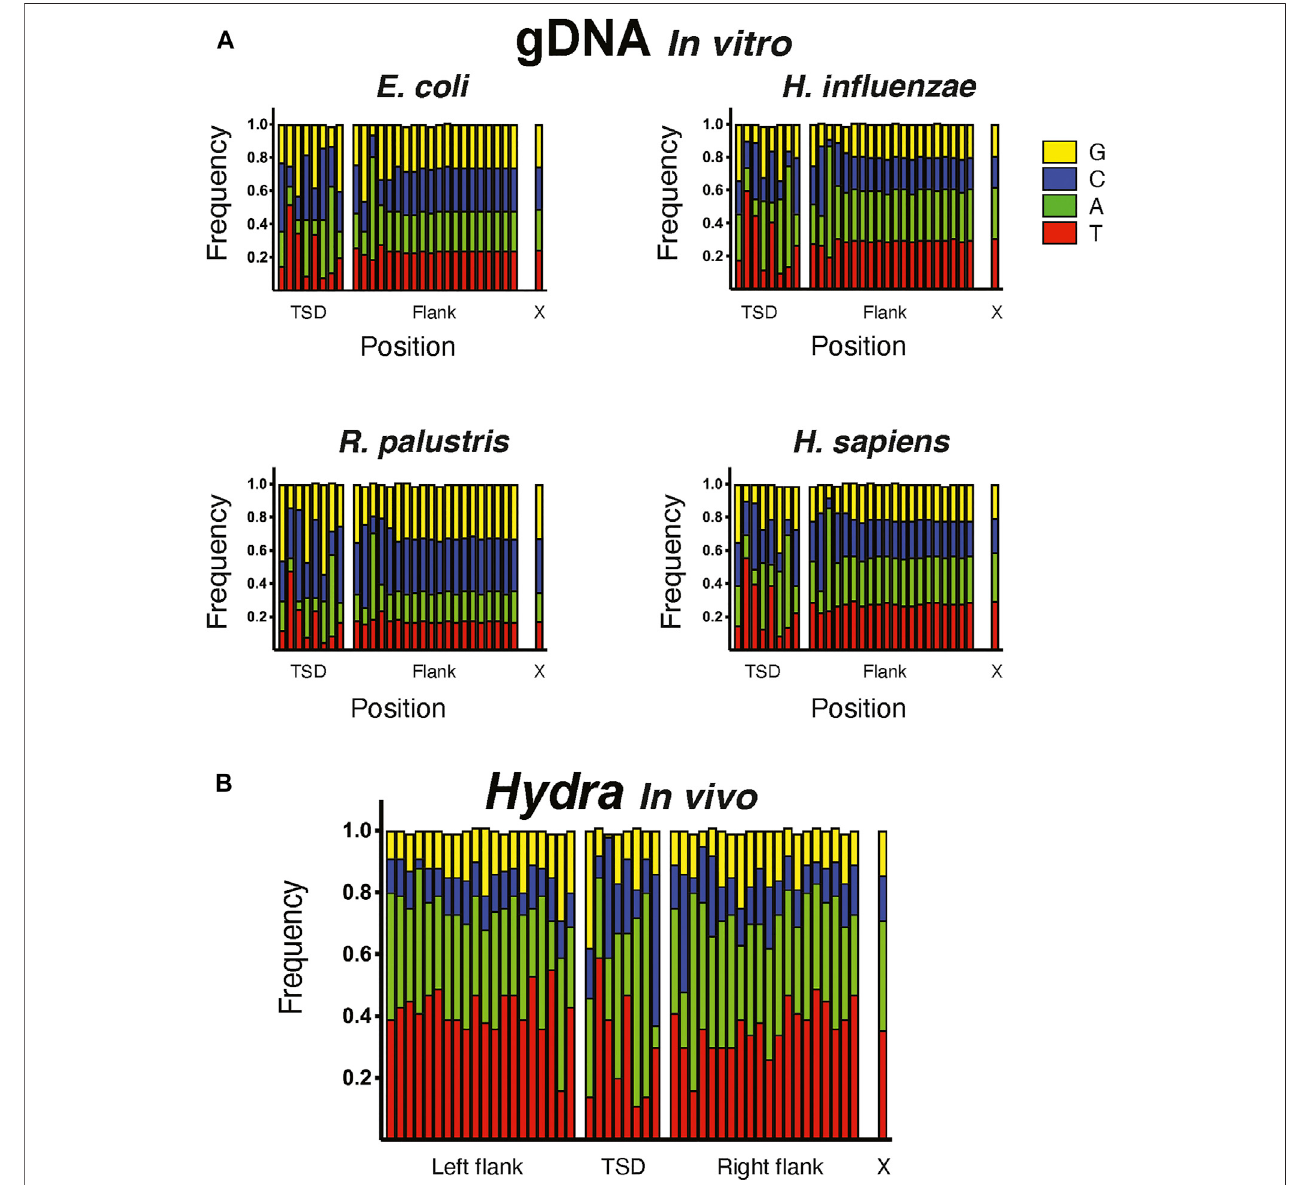
FIGURE4| TargetsitepreferenceofhATx-6transposase.Graphsdepictingthe8 bptargetsiteduplicationregion(TSD),the20 bp fl ankingtheduplicationsiteand X denotes the natural composition of nucleotides in the genome of the organism. G bases are shown in yellow, C in blue, A in green and T in red. (A) The insertion site preference of hATx-6 in E. coli , H. in fl uenzae , R. palustris , and H. sapiens DNA. (B) The combined results of the sites found in the bioinformatic analysis of the Hydra genomic DNA.